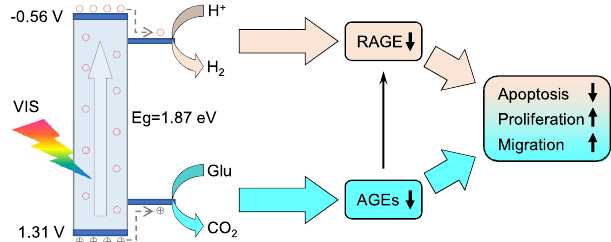
Fig. 1 | Schematic illustration of the mechanism for visible light-triggered photocatalytic therapy of diabetic wound based on HTON. HTON as a VIS- responsivephotocatalystpossessesarightenergybandstructurewhichenablesto utilizeglucose(Glu)inthehigh-glucosemicroenvironmentasasacri fi cialagentfor ef fi cientVIS-photocatalytichydrogengeneration.Photocatalyticglucosedepletion andgeneratedhydrogenmoleculesinhibitthesynthesisofadvancedglycationend products (AGEs) and the expression of their receptors (RAGE) in the micro- environmentofdiabeticwound,respectively,jointlyblockingtheapoptosisofskin cells and promoting their proliferation and migration in support of ef fi cient dia- betic wound